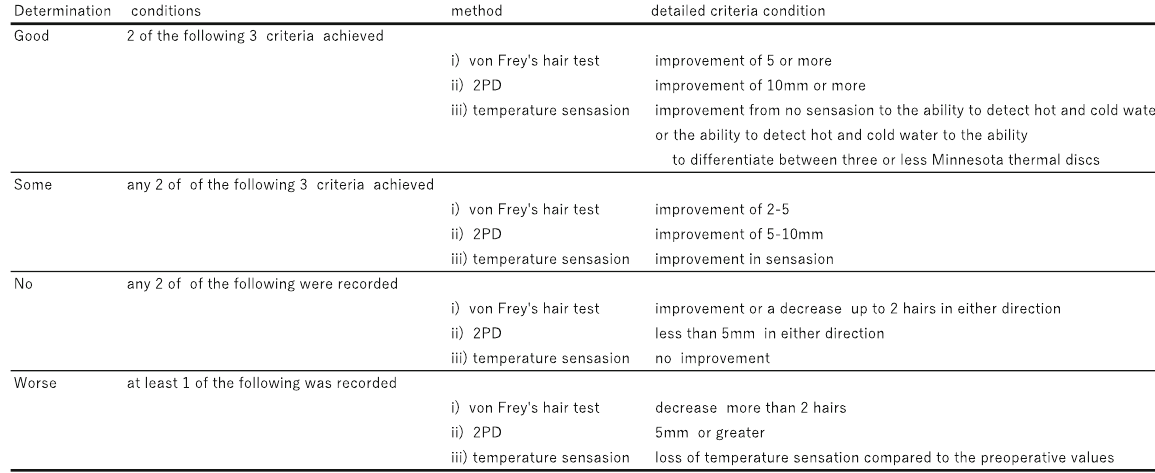
Table 8 Pogrel ’ s postsurgical